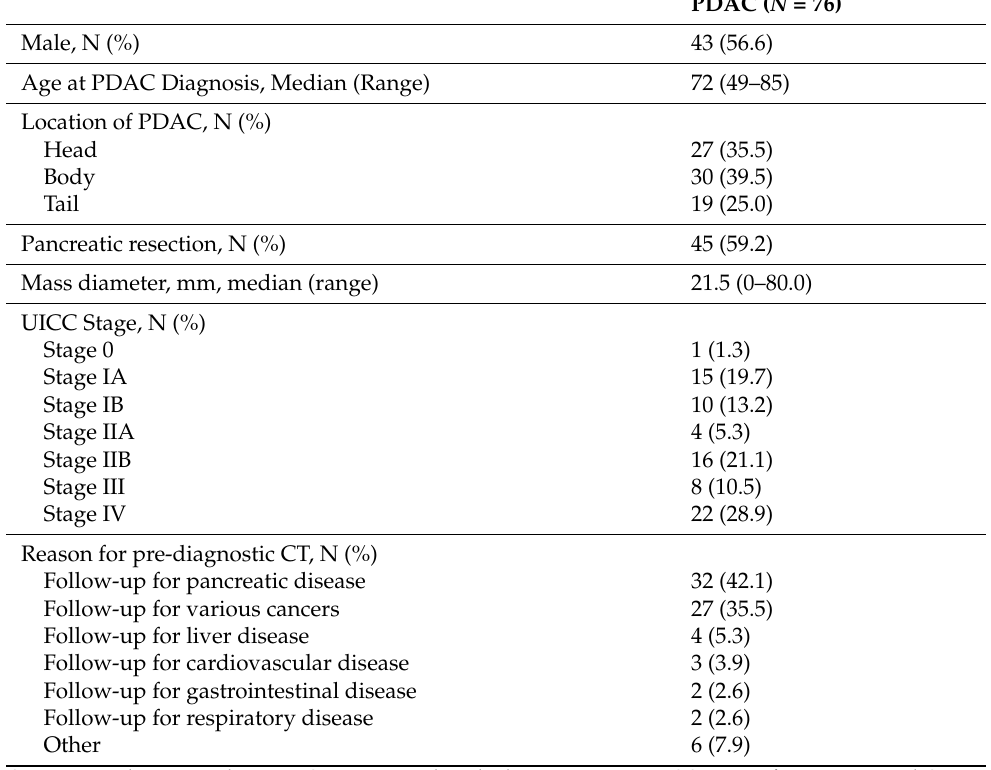
Table 1. Characteristics of the patients who underwent pre-diagnostic